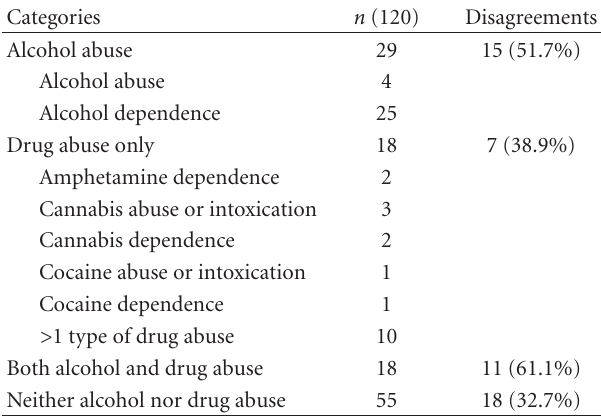
Table 2: Frequencies of substance abuse